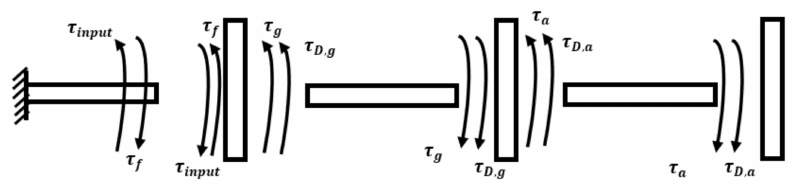
Figure 4. Nonlinear robotic arm free body